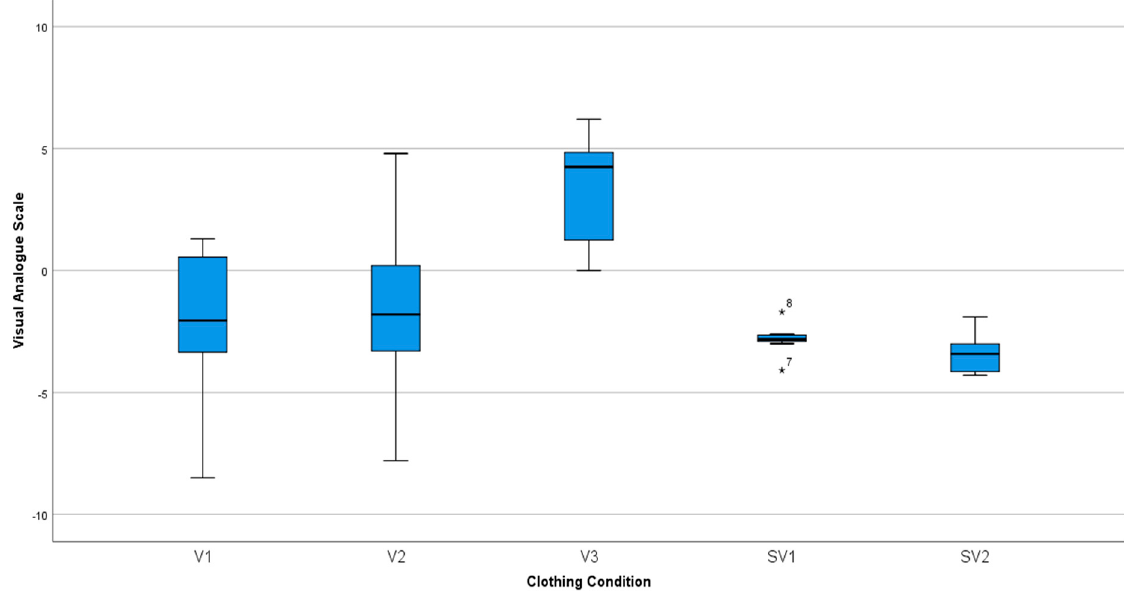
Figure 9. Subjective results of the Step-up Task compared to station wear.